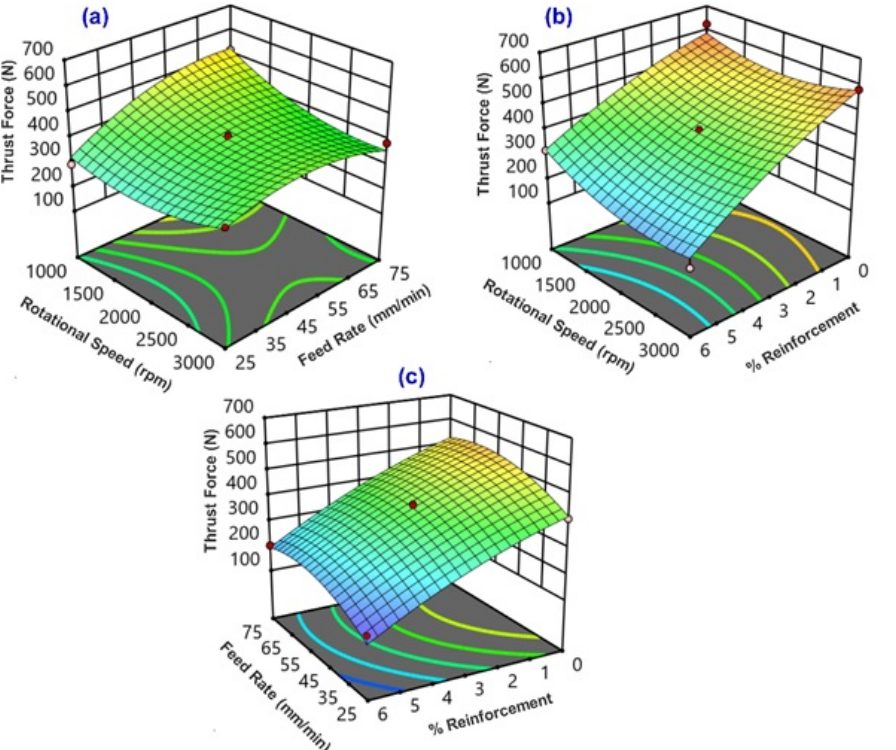
Figure 10. Response surface plots of thrust force ( a ) rotational speed, feed rate vs. thrust force ( b ) rotational speed, % reinforcement of mica vs. thrust force and ( c ) feed rate, % reinforcement of mica vs. thrust force.